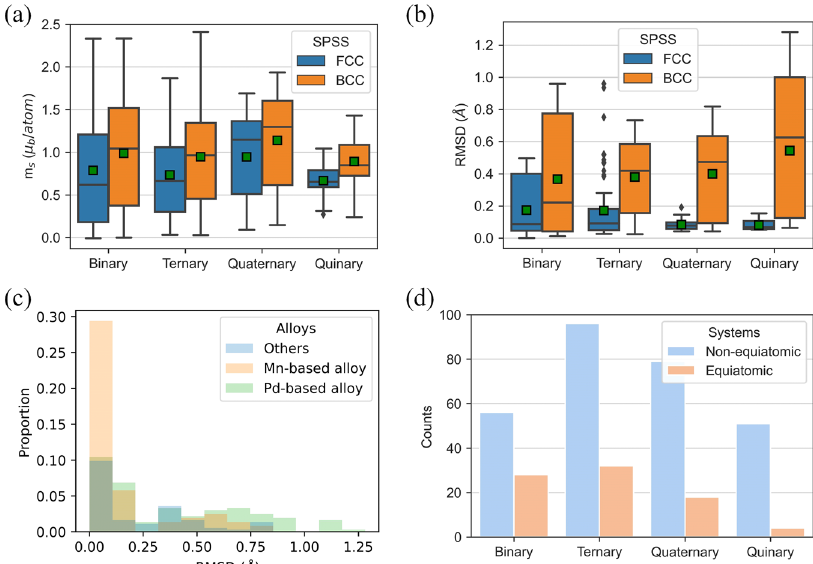
Fig. 3 Data set descriptions for the CrFeNiCoMn/Pd and their subsystems. Statistical box plot over different types of subsystems in solid- solution FCC and BCC phases for a magnetic moments and b RMSD. The mean values and median values are represented with green squares and black lines in the interquartile range. The box region shows the 25 – 75% percentile range, and the whiskers extend to 1.5 times the interquartile range. c Histogram of the RMSD for different kinds of alloys (Mn-based alloys, Pd-based alloys, and others.) d The statistics of different representation. For the readout feature vectors of Co 3 Cr alloy, see Supplementary Figs. 1, 2. Application in HEAs